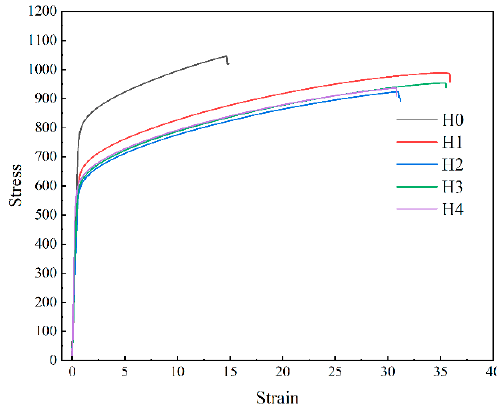
Figure 11. Tensile strength of deposited specimens.